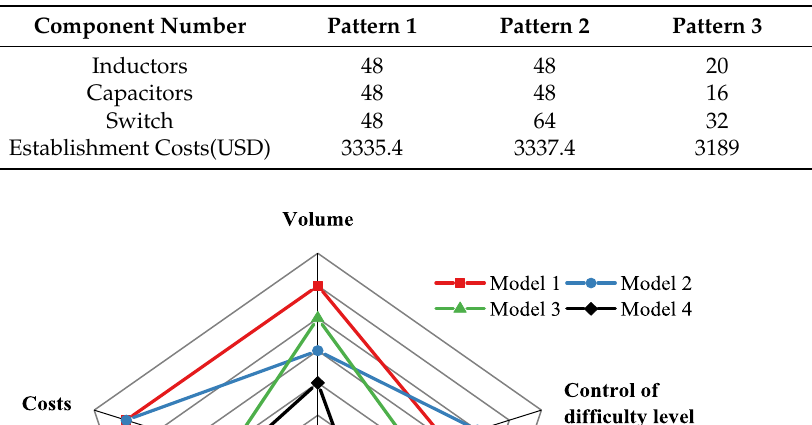
Table 7. Discharge equalization experimental data.